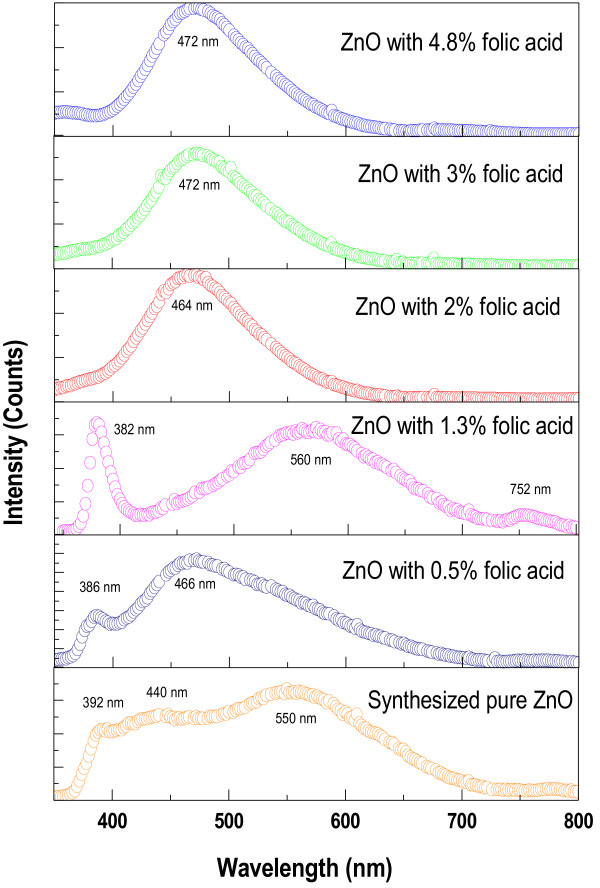
Photoluminescence spectra of (a) pure ZnO, (b) Z0.5, (c) Z1.3, (d) Z2.0, (e) Z3.0, (f) Z4.8samples.